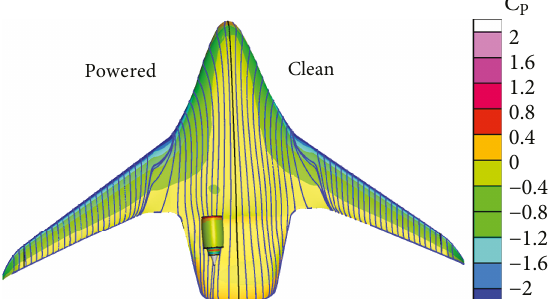
Figure 18: Upper surface pressure contour and streamlines of the clean and powered con fi gurations at 9 ° (low speed).